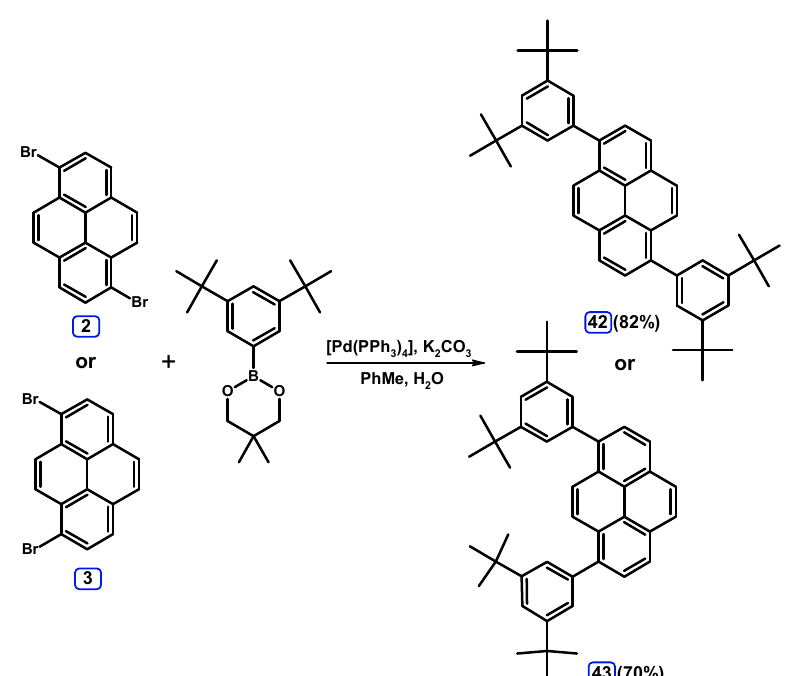
Scheme 25. Suzuki-Miyaura coupling reaction with 5,5-dimethyl-2-(3,5-di- tert -butylphenyl)-1,3,2- dioxaborinane